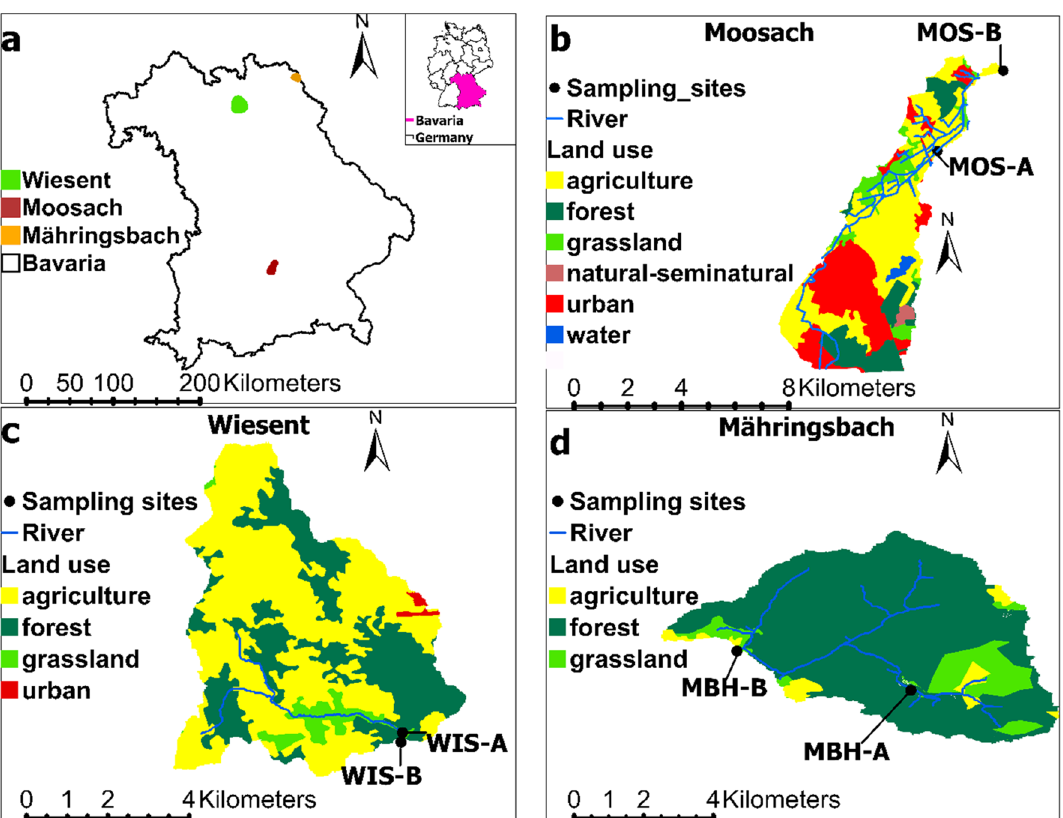
Figure 2. Studied streams with land use characteristics upstream of sampling sites. ( a ) Overview map of Bavaria with locations of the three streams Mähringsbach (MBH) in orange, Wiesent (WIS) in green and Moosach (MOS) in red with their respective catchments. Subfigures ( b – d ) mark detailed land use patterns of MOS, WIS and MBH catchment sections, respectively, while study sites A and B represent upstream and downstream locations. The map was created with the geographic information system (GIS) software ArcGIS Pro, version 2.7.2 (https:// www. esri. com/ en- us/ arcgis/ produ cts/ arcgis- pro/ overv